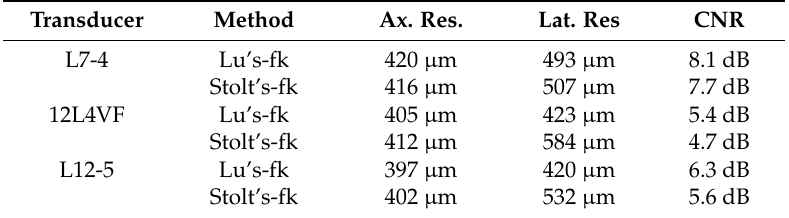
Table A3. Axial and lateral resolution, and CNR by Lu’s-fk and Stolt’s-fk without angular